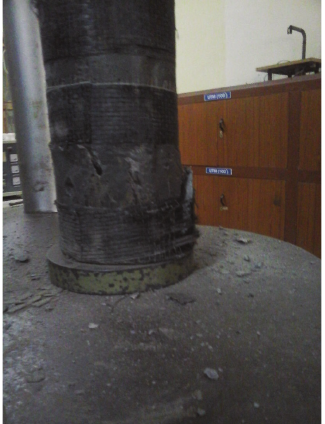
Figure 5: Failure pattern of NC-20-2.